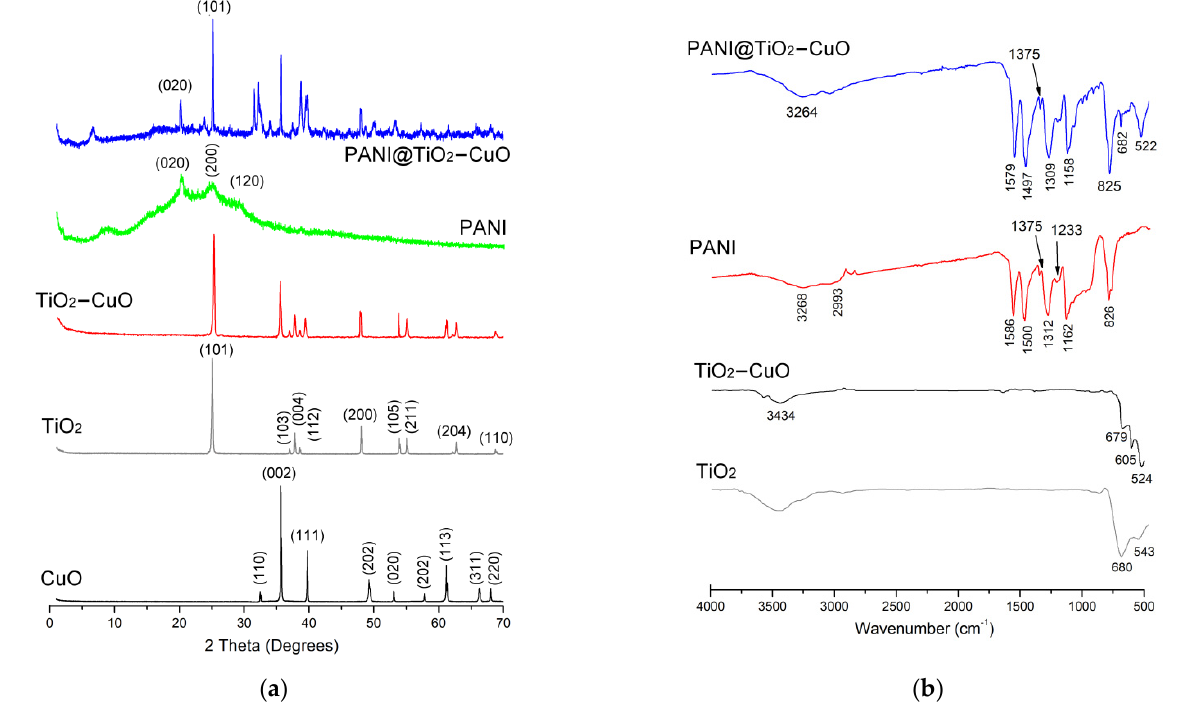
Figure 1. ( a ): XRD patterns and ( b ): FTIR analysis of samples.